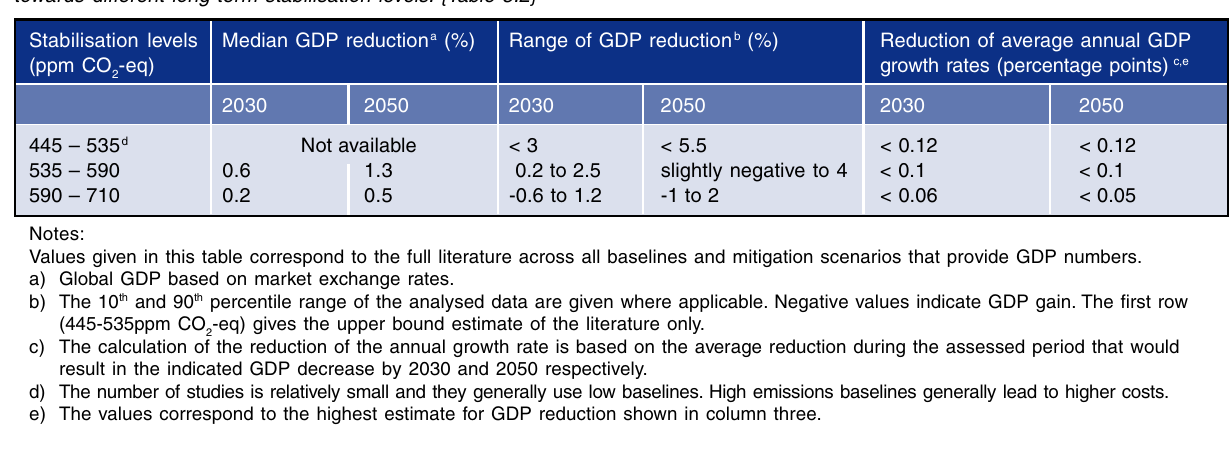
Table SPM.7. Estimated global macro-economic costs in 2030 and 2050. Costs are relative to the baseline for least-cost trajectories towards different long-term stabilisation levels. {Table